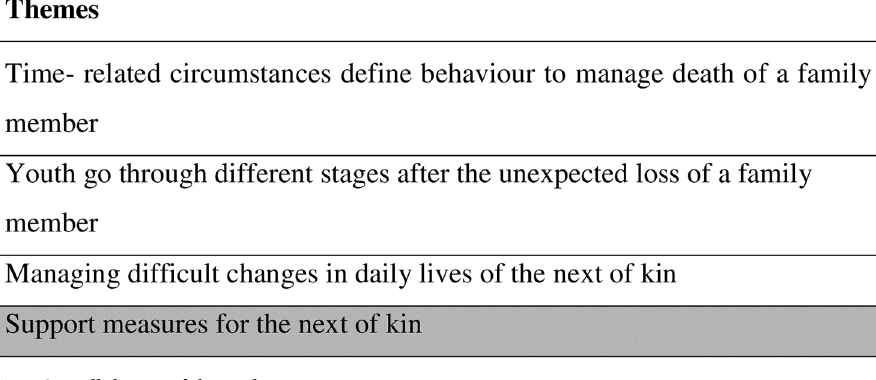
Fig 1. Overall themes of the